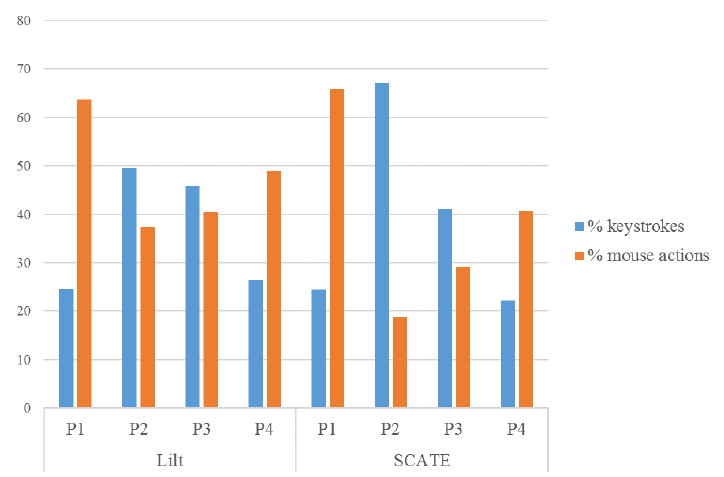
Figure 15. Percentage of time devoted to keystrokes vs. mouse actions per translation environment per